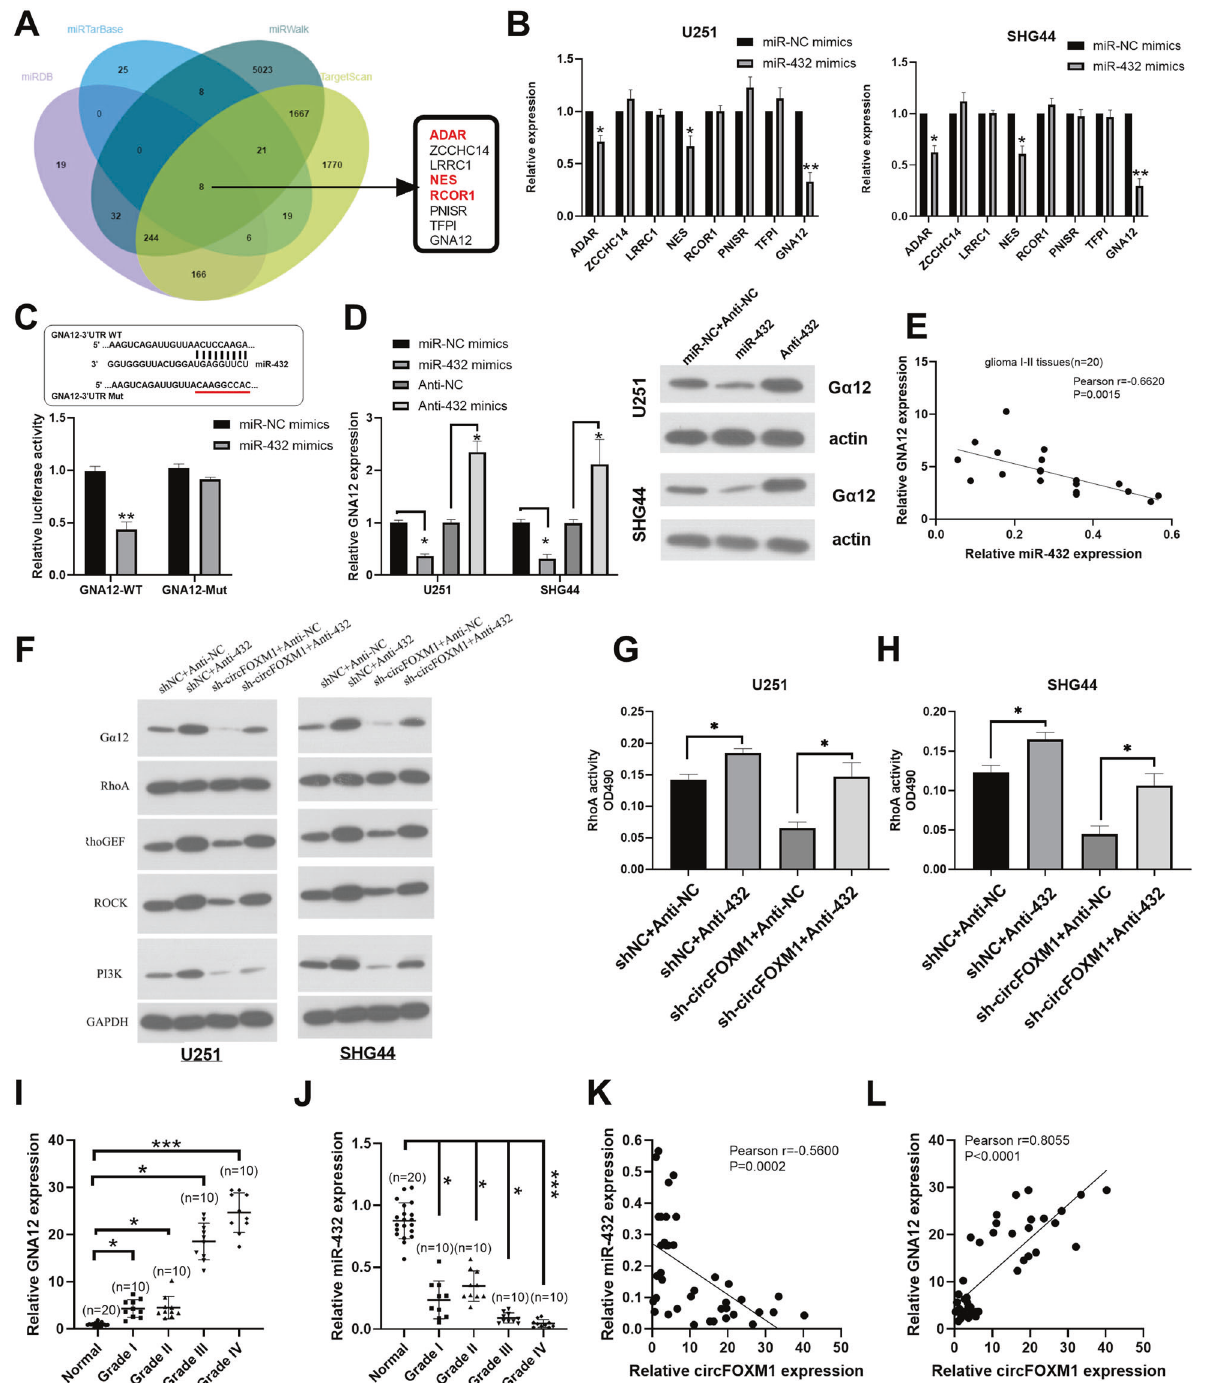
Fig. 6 circFOXM1 binds miR-432 to regulate the expression of G α 12 and the RhoA signalling pathway. A A total of 8 targeted mRNAs of miR-432 from four online databases. B The interrelation between targeted mRNAs and miR-432 was veri fi ed by qRT-PCR. C Luciferase-reporter activity of constructed plasmids (G α 12-WT or G α 12-MUT) in glioma cells cotransfected with miR-432 mimics or miR-NC mimics. D Relative expression of G α 12 in U251 and SHG44 cells transfected with miR-432 mimics or miR-432 inhibitor. E The Pearson correlation between G α 12 and miR-432 levels was measured in the same set of glioma tissues. The Δ Ct values (normalized to GAPDH) were subjected to Pearson correlation analysis (R = − 0.6620, P = 0.0015). F – H Western blotting was used to measure the expression of the RhoGEF/RhoA/ROCK/PI3K pathway. I , J The relative expression of G α 12 and miR-432 in glioma tissues of different grades. K The Pearson correlation between circFOXM1 and miR-432 levels was measured in the same set of glioma tissues. The Δ Ct values (normalized to GAPDH) were subjected to Pearson correlation analysis ( R = − 0.5600, P = 0.0002). L The Pearson correlation between circFOXM1 and G α 12 levels was measured in the same set of glioma tissues. The Δ Ct values (normalized to GAPDH) were subjected to Pearson correlation analysis ( R = 0.8055, P < 0.0001) (* P < 0.05, ** P <